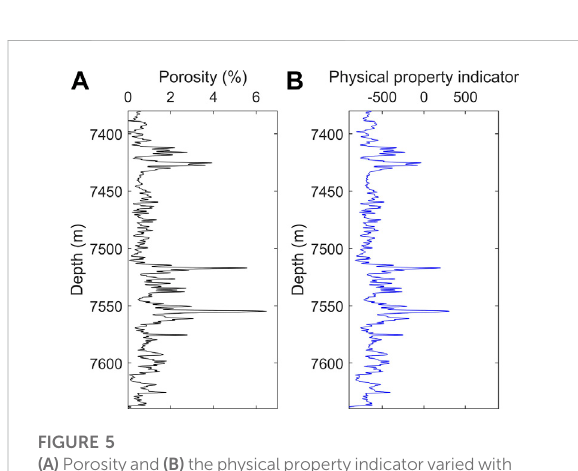
FIGURE 5 (A) Porosityand (B) thephysicalpropertyindicatorvariedwith depth in Well 4.